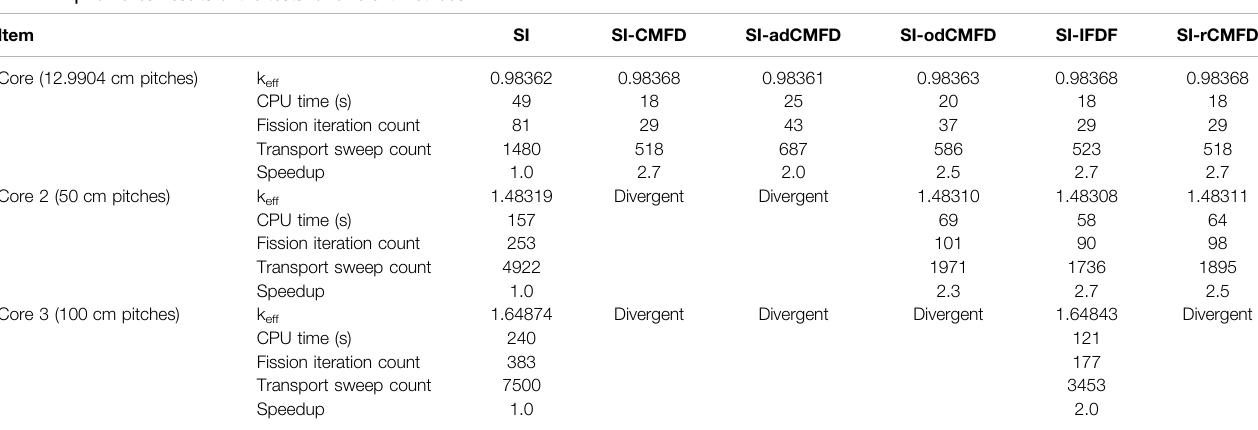
TABLE 1 | Numerical results of the tests for different methods.